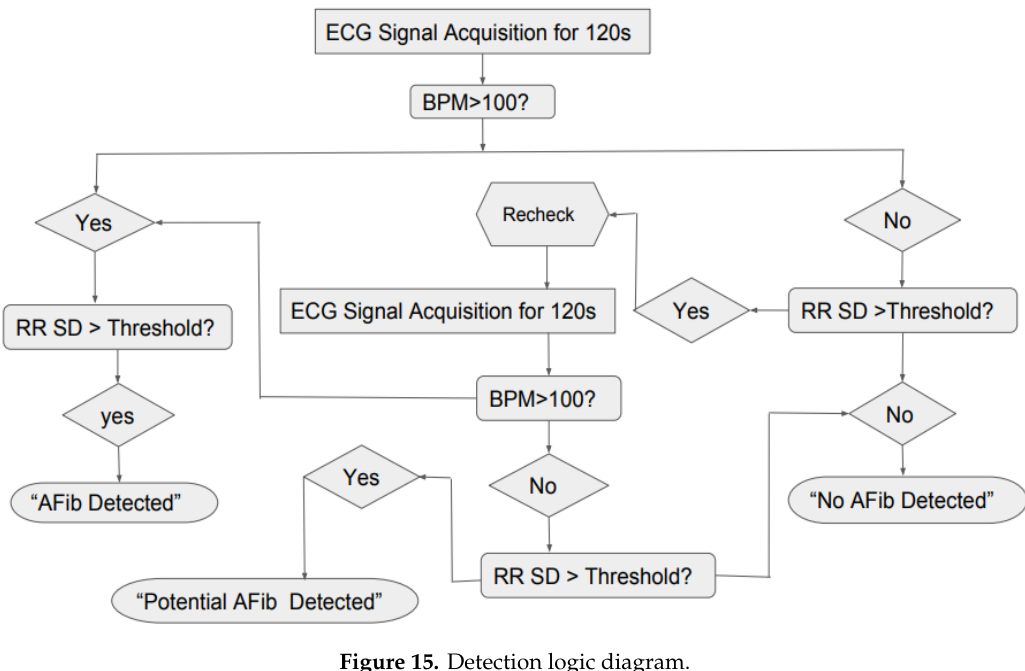
Figure 15. Detection logic diagram.